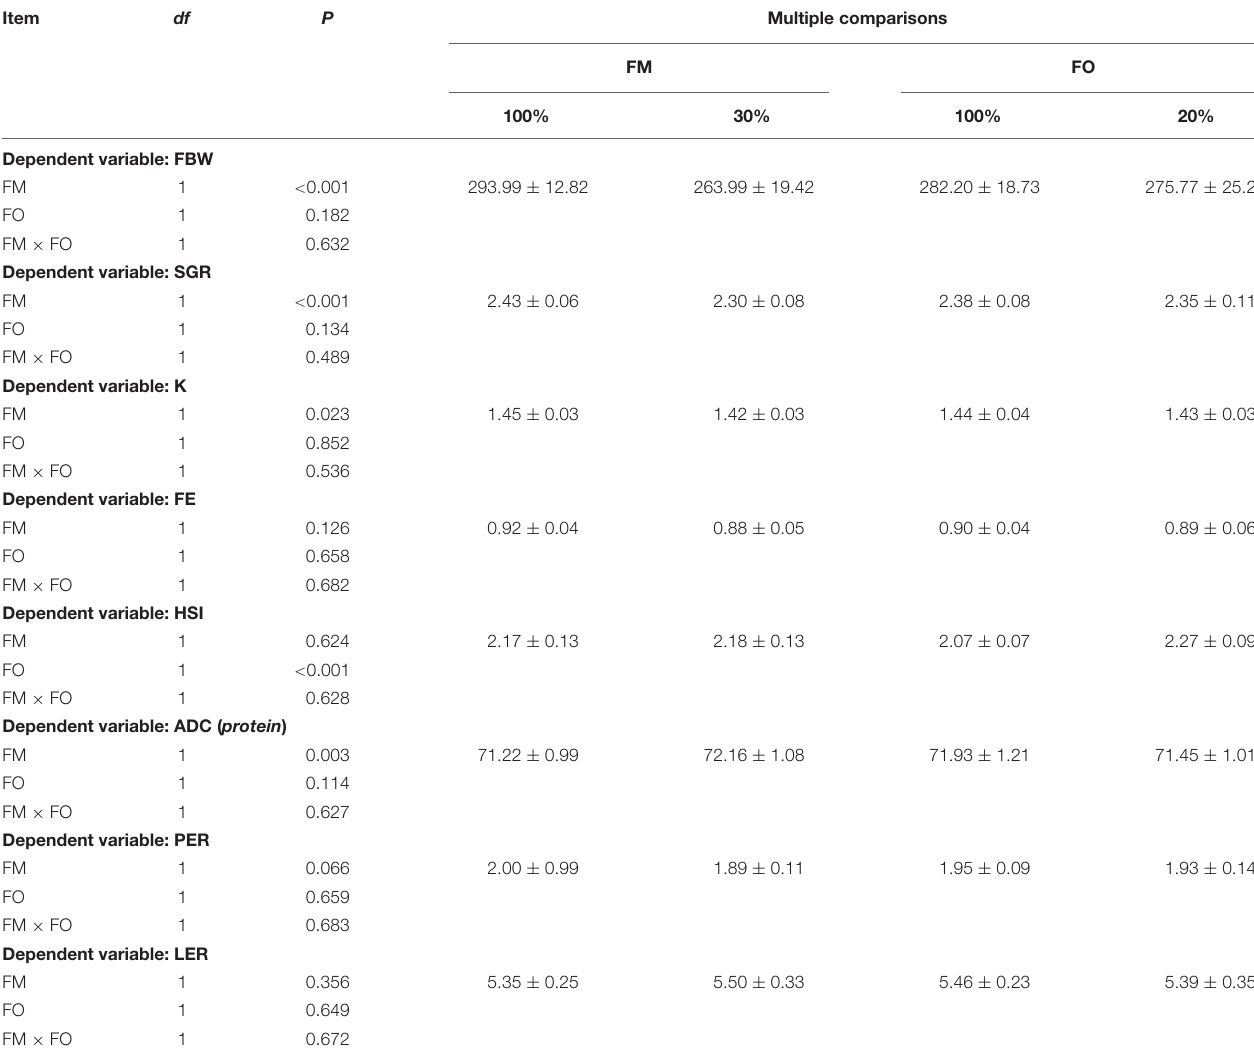
TABLE 2 | Two-way factorial analysis of variance (ANOVA) for the growth performance and feed utilization of O. mykiss fed different diets. Item df P Multiple